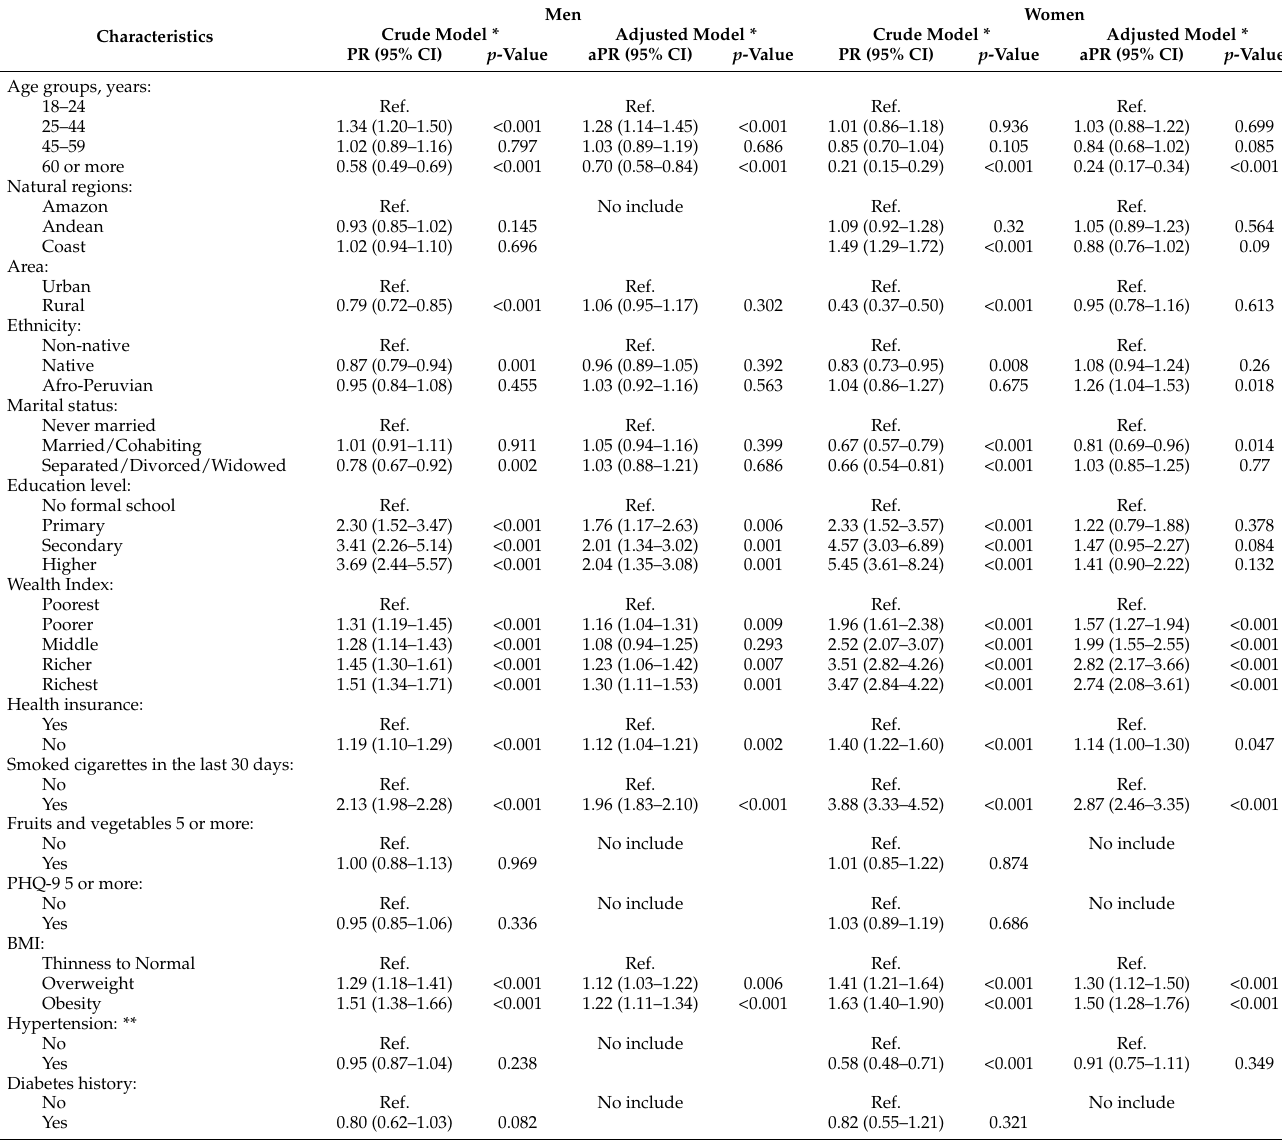
Table 3. Crude and adjusted prevalence ratios among men and women for several socioeconomic and health-related